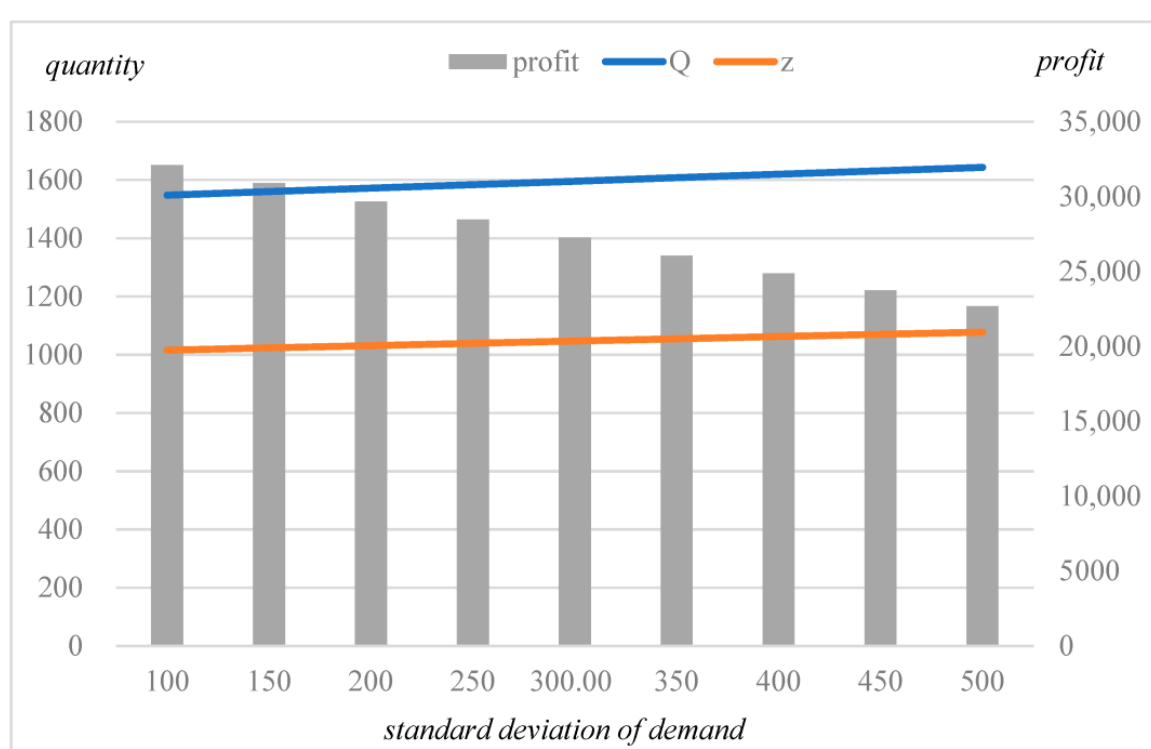
 . Figure 5. The results for various standard deviations of demand σ D D